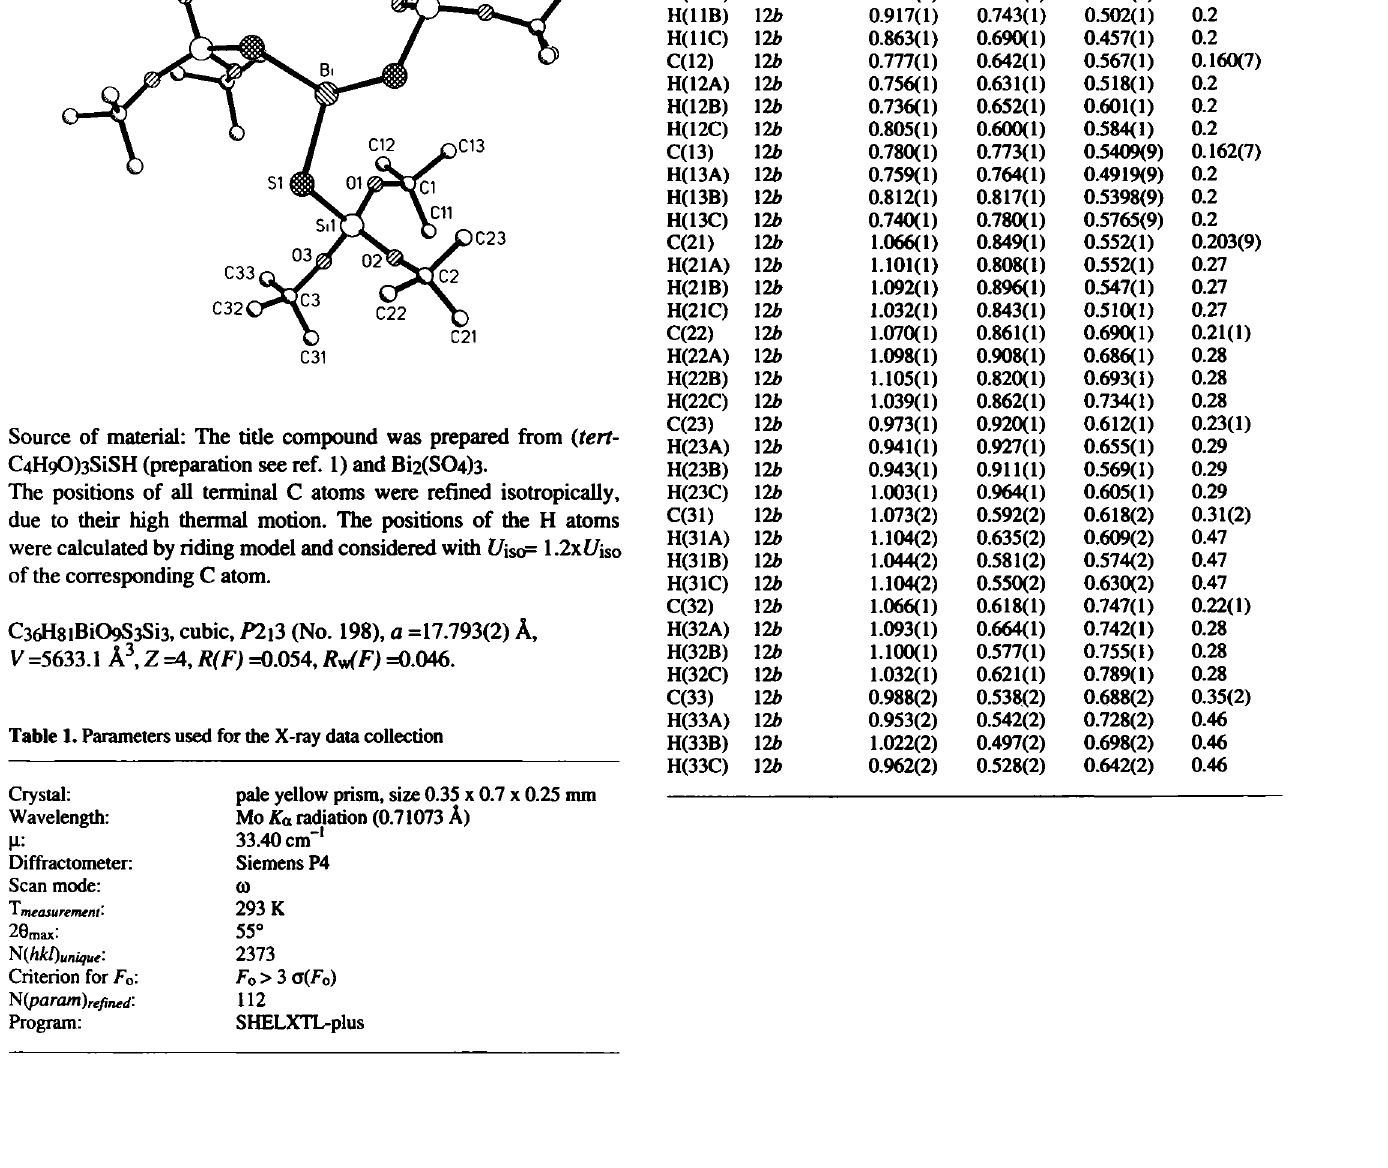
Table 2. Final atomic coordinates and displacement parameters (in A 2 )